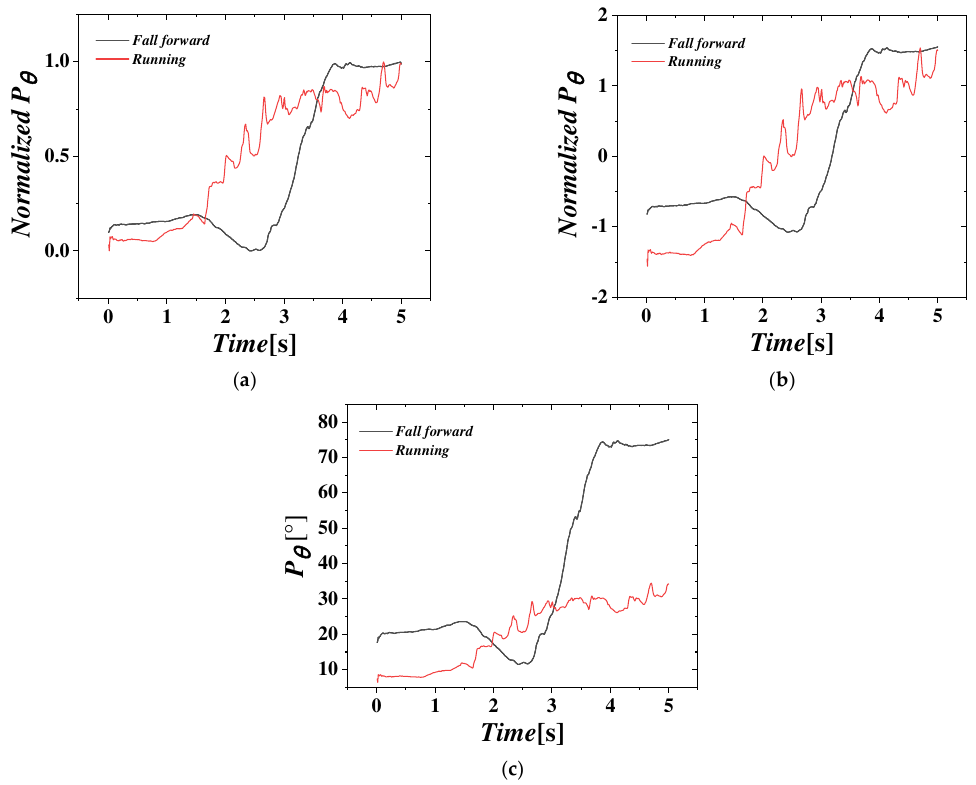
Figure 10. Comparison of data of running and forward fall before and after normalization. ( a ) min-max normalization, ( b ) Z-score normalization, ( c ) No-normalization.